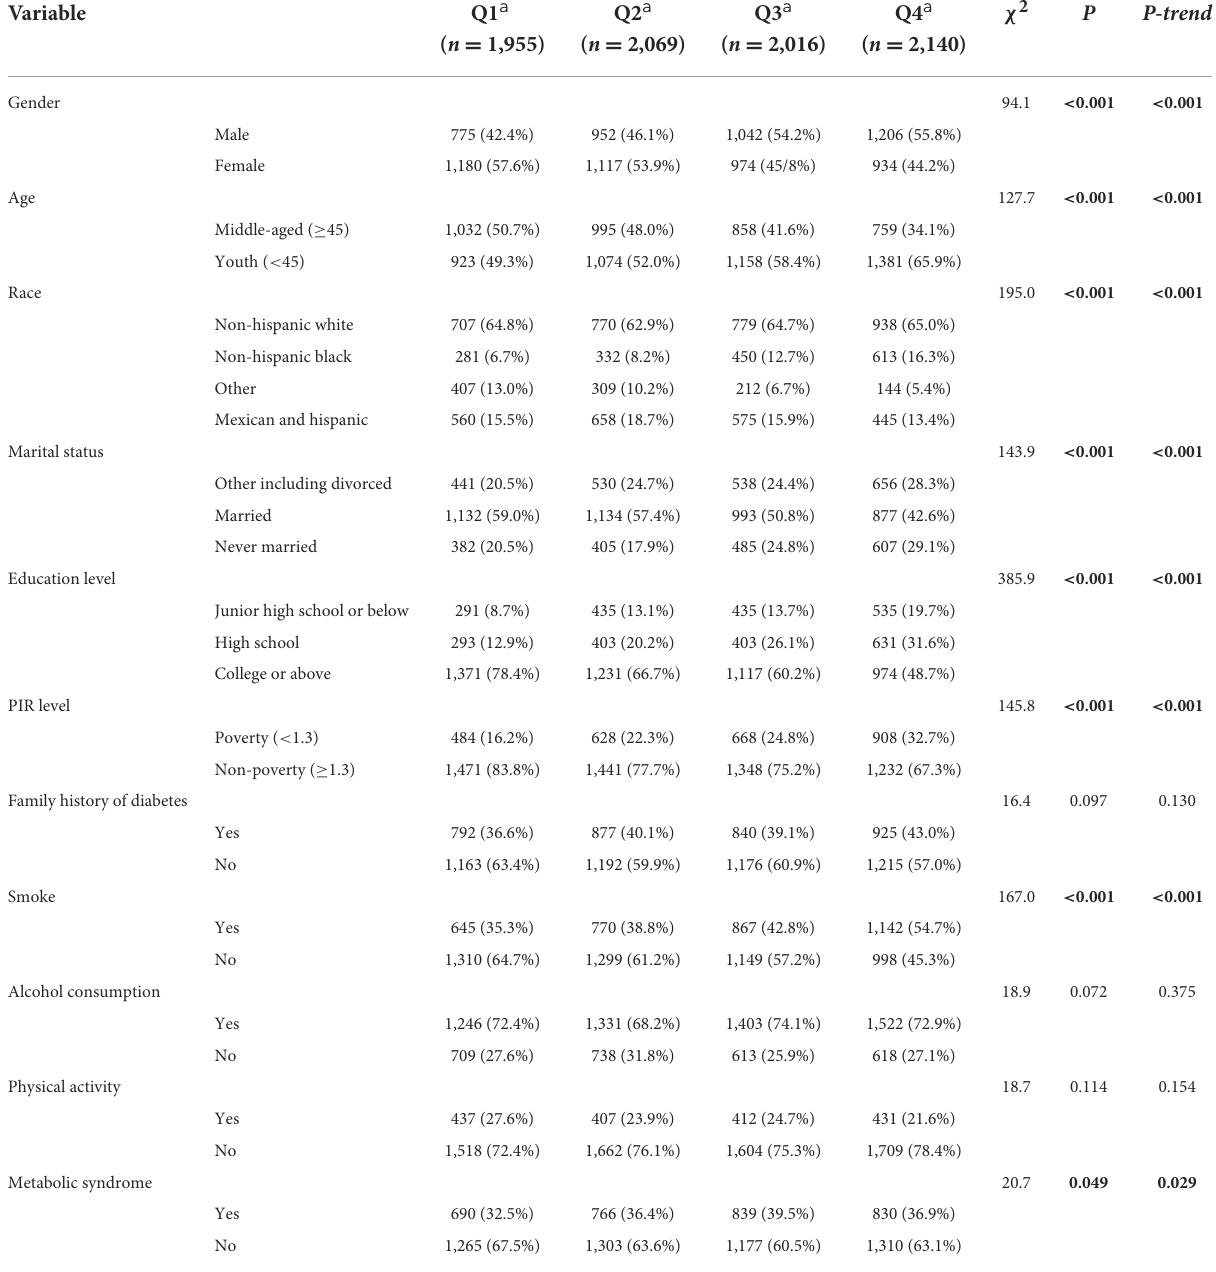
TABLE 1 The distribution of the basic situation of the subjects in 4 DII quartile groups [ n (%)]. Variable